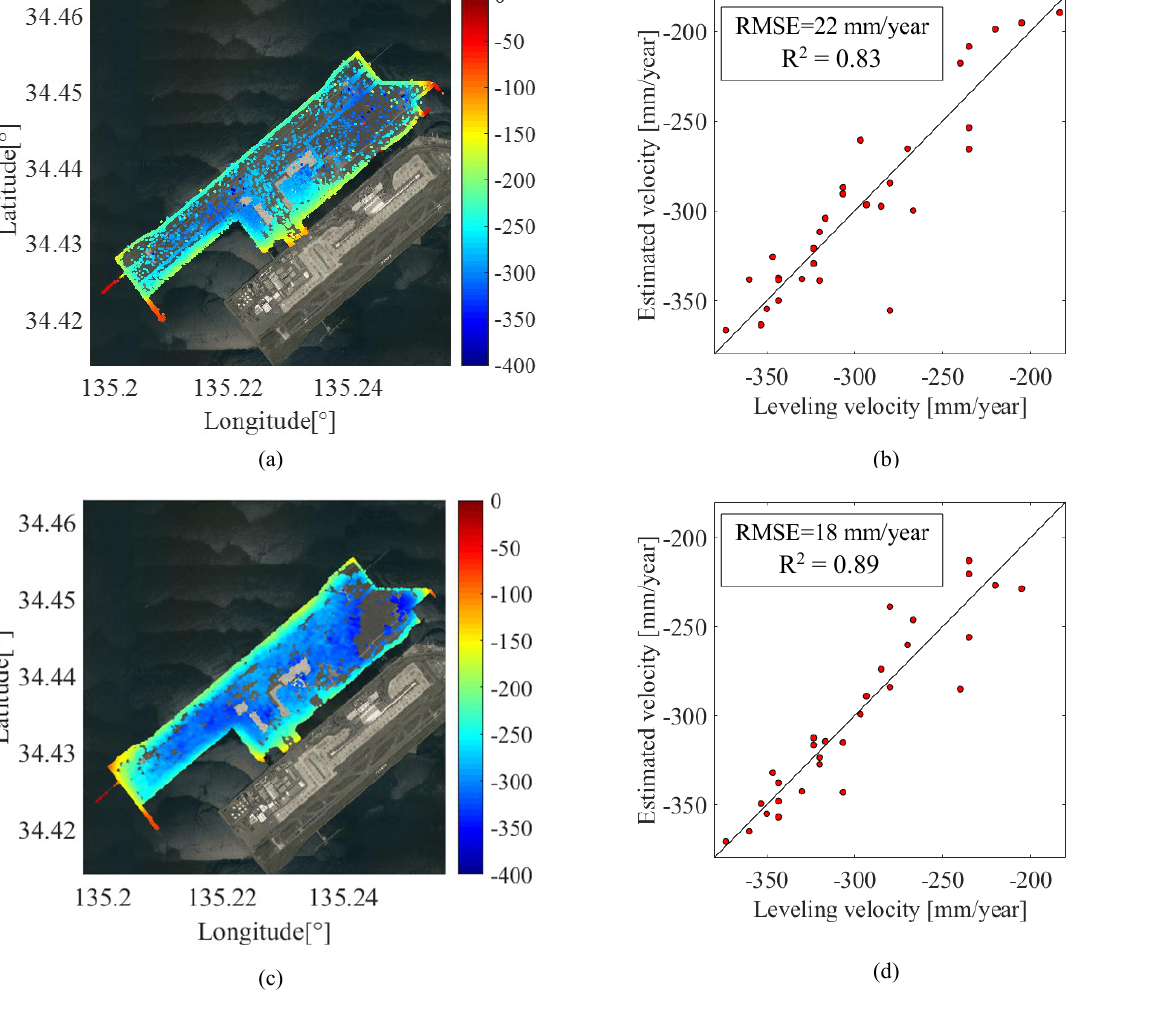
Figure 5. PSI results: (a) mean velocity field from ascending data in mm/year, (b) validation results from ascending data, (c) mean velocity field from descending data, and (d) validation results from descending data. Map data